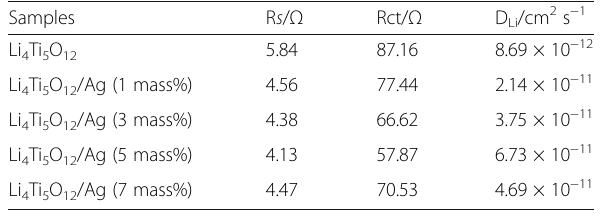
Table 2 Impedance parameters of the pure Li 4 Ti 5 O 12 and the Li 4 Ti 5 O 12 /Ag composites coated with different silver contents